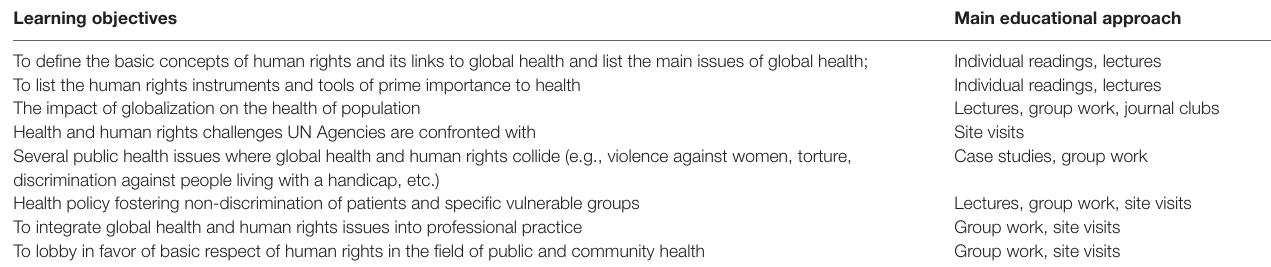
table 4 | Achievement of learning objectives through various educational